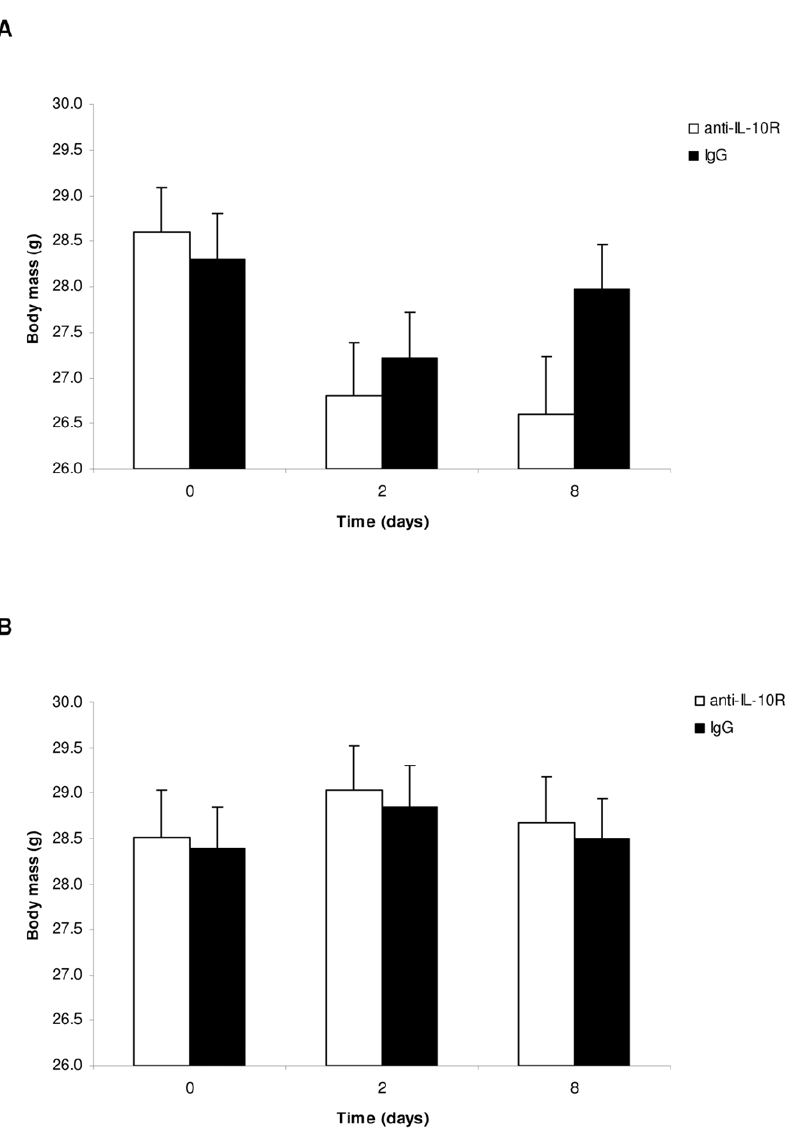
Figure 2. Temporal change in body mass of mice treated with anti-IL-10R antibodies or IgG. (A) LPS; (B) PBS. The bars represent the mean 6 SE.